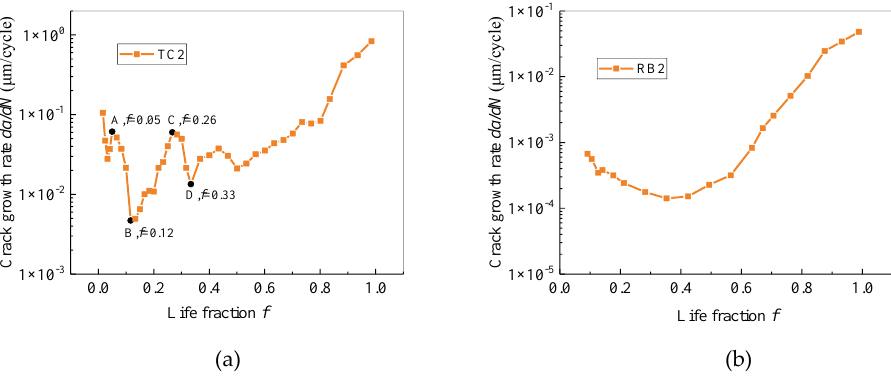
Figure 8. Curve of crack growth rate as a function of life fraction: ( a ) TC specimen; ( b ) RB specimen.